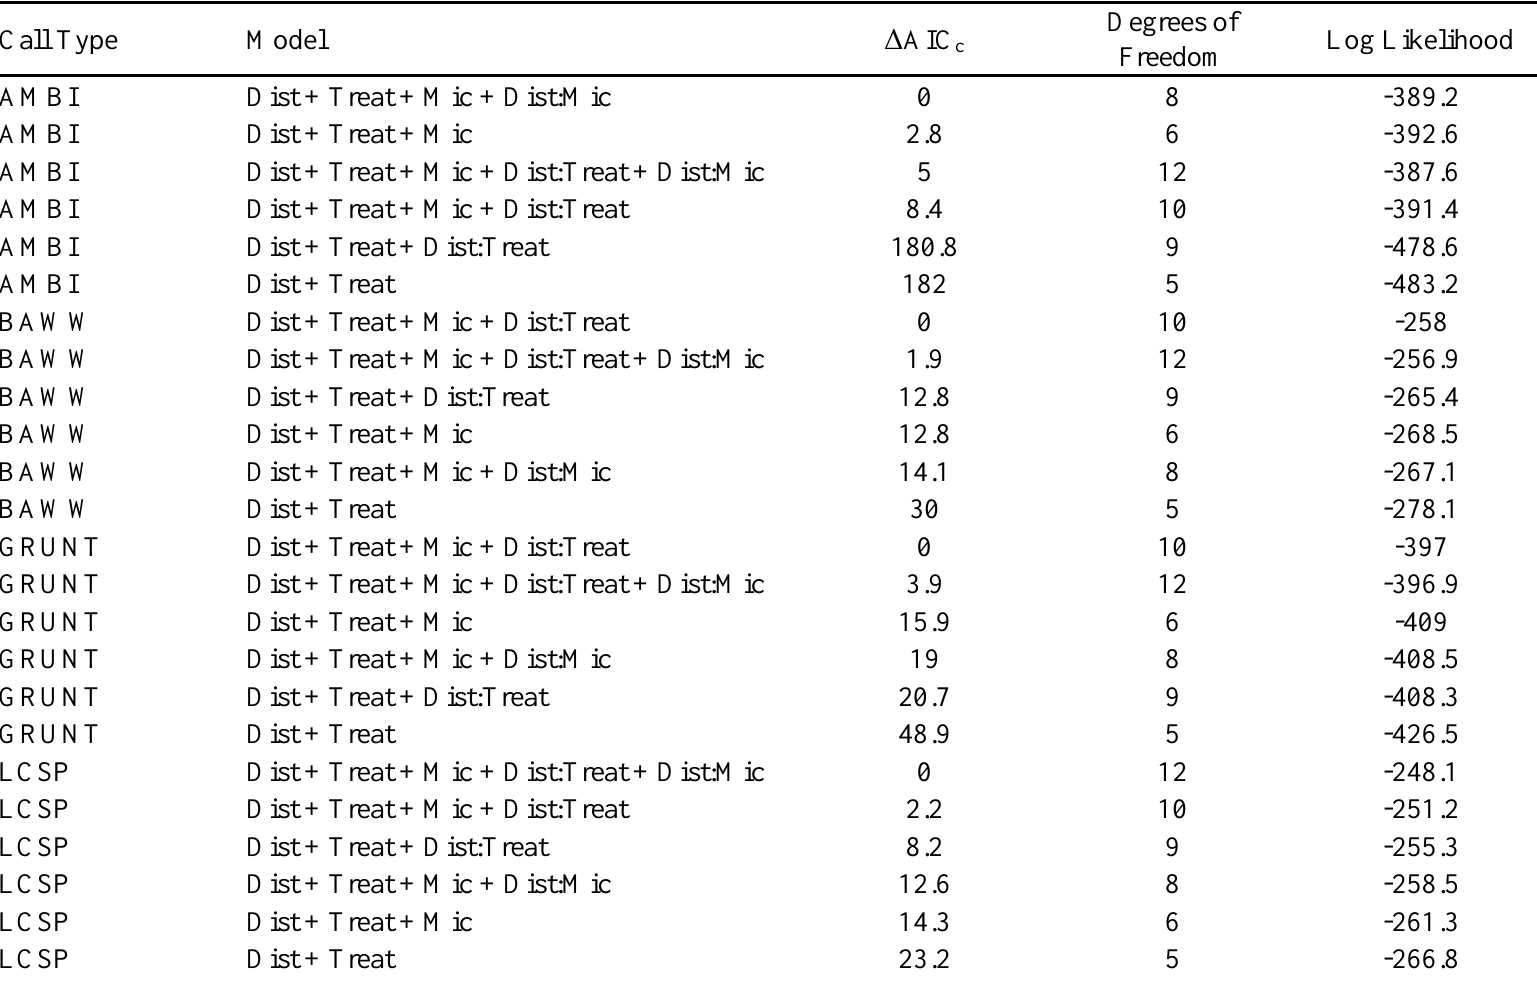
) for each call type. c